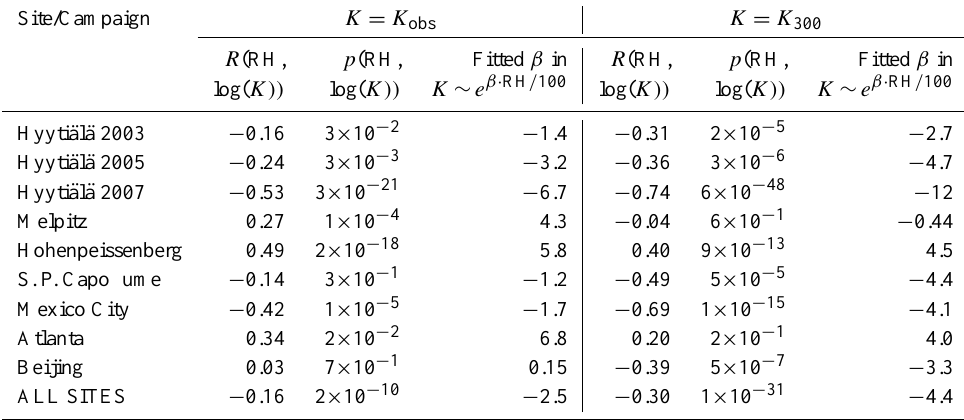
Table 3. Numerical comparison of the RH dependencies of the observed coefficients K at the measured temperature ( K = K obs ) and when K obs is scaled to T = 300 K ( K = K 300 ) . Presented values are the correlation coefficient R , the p-value describing the probability of coincidental correlation of this strength, and the value of β in K = α · exp( β · RH) from linear regression fits. The compared values of K 300 are scaled to 300 K with the temperature dependence of coefficient K A2T2 from the model run with organic vapours, but the correlations were similar when scaling was done with the temperature dependence of any of the coefficients K A2D2 , K A2T2 or K A2D1T1 . Site/Campaign K = K obs K = K 300 R (RH, p (RH, Fitted β in R (RH, p (RH, Fitted β in log( K)) log( K)) K ∼ e β · RH / 100 log( K)) log( K)) K ∼ e β · RH / 100 Hyyti¨al¨a 2003 − 0.16 3 × 10 − 2 − 1.4 − 0.31 2 × 10 − 5 − 2.7 Hyyti¨al¨a 2005 − 0.24 3 × 10 − 3 − 3.2 − 0.36 Hyyti¨al¨a 2007 − 0.53 3 × 10 − 21